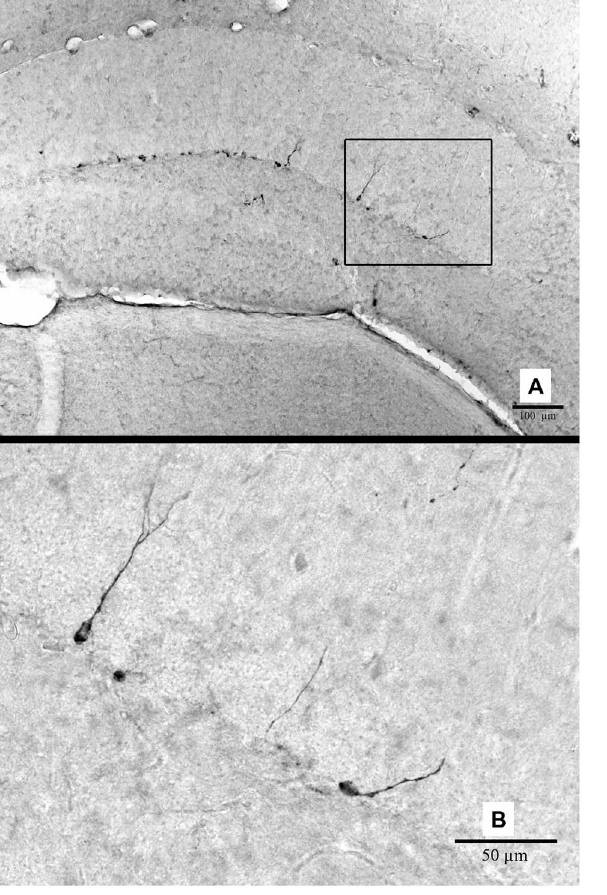
Figure 3. Representative image of doublecortin-positive (Dcx + ) cells in the hippocampus of a 12-month-old wild-type mouse. A: Image taken using an 10 6 objective. Scale bar=100 m m. B: Image taken with an 40 6 objective. Scale bar=50 m m.